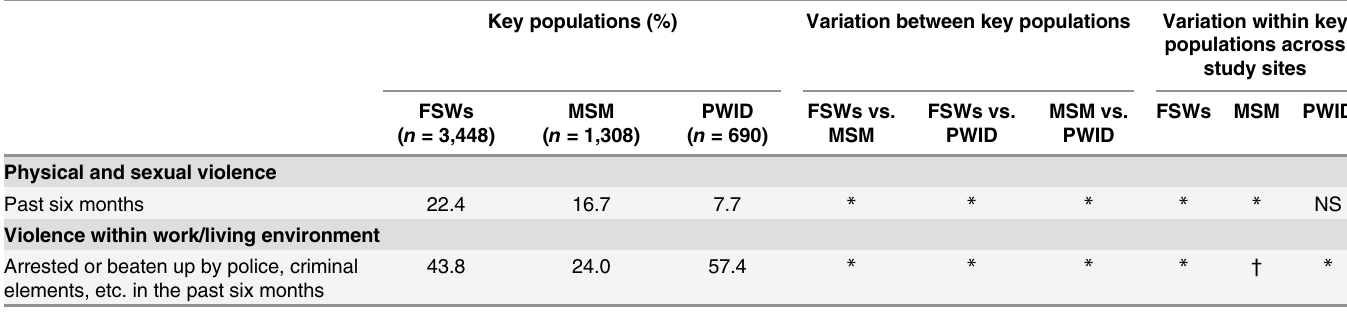
Table 5. Reported experiences of violence among polling booth survey participants. Key populations (%) Variation between key